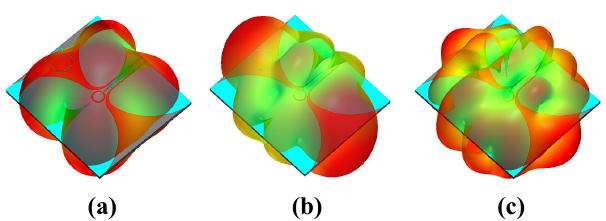
Figure 10: Simulated 3D radiation patterns for the proposed antenna at the frequencies: (a) f=4.5GHz, (b) f =6.77 GHz and (c) f =10 GHz.